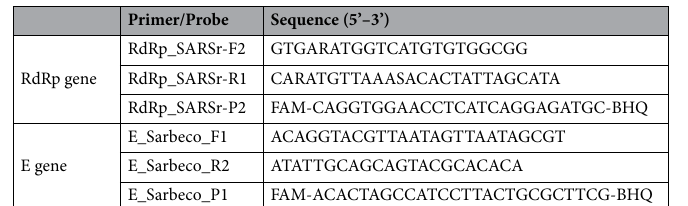
Table 1. Primers and probes used to detect SARS-CoV-2. R is G/A; FAM, 6-carboxyfluorescein; BHQ, black hole